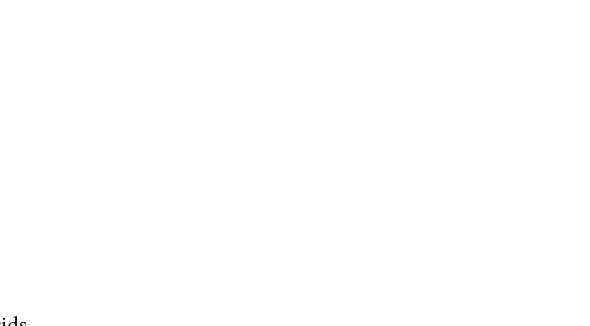
Table 2. Technological parameters of